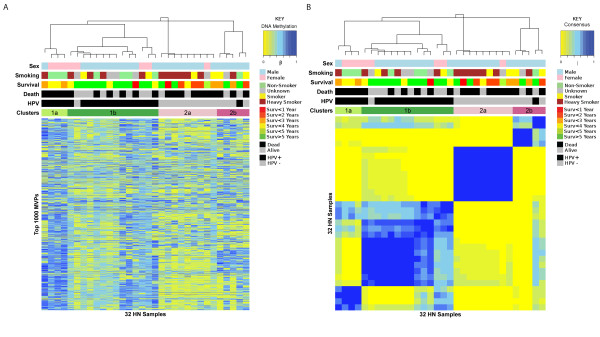
Unsupervised analysis of the top 1,000 MVPs in formalin-fixed, paraffin wax-embedded (FFPE) human papillomavirus-positive (HPV+) and HPV-negative (HPV-) tumor samples. (A) Consensus clustering identified four sub-groups in HPV+ and HPV- groups, revealing sub-group 1a as candidate CIMP within the HPV+ group. (B) Clusters inferred by the unsupervised consensus-clustering algorithm for the top 1,000 MVPs as found using the MAD estimator.